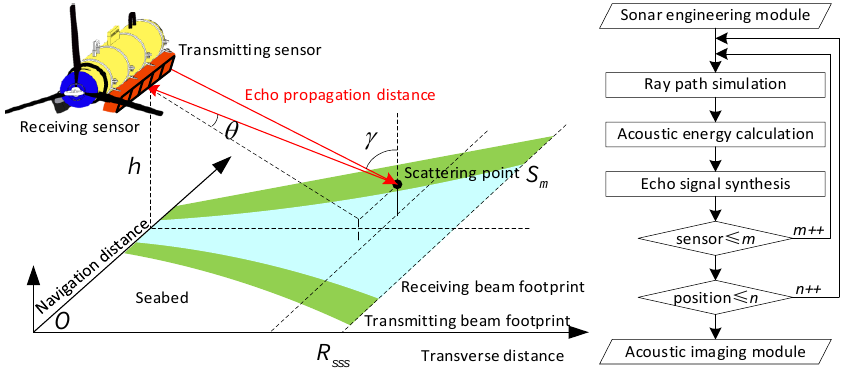
Figure 3. Schematic diagram of the ray − tracing algorithm.